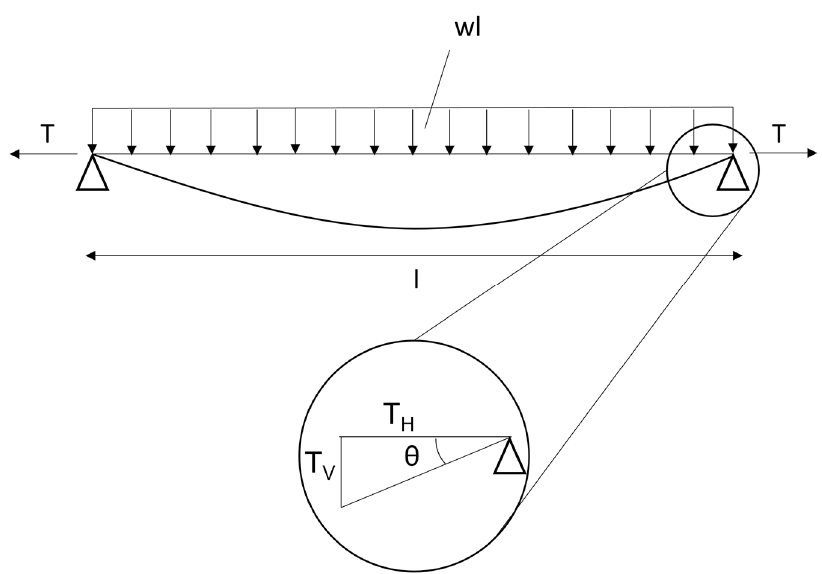
Figure 2. Schematic representation of a conductor span of length l modelled according to the “flat parabola method”.